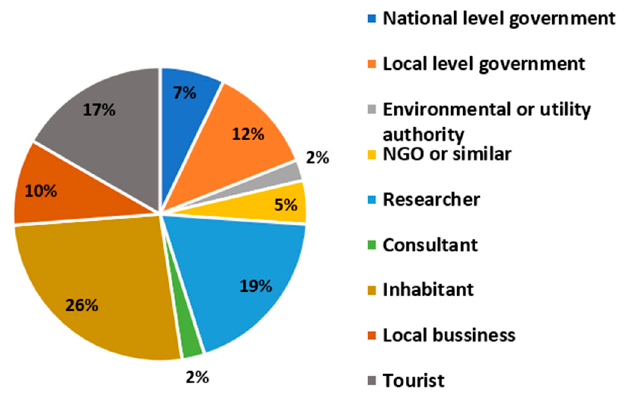
Figure 5. Type of stakeholders that answered the questionnaire ( N = 42).